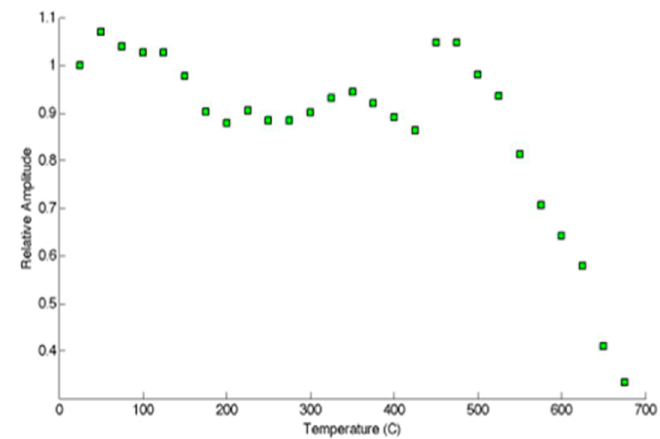
Figure 7. Temperature dependence of pulse-echo amplitude for Bi 4 Ti 3 O 12 / LiNbO 3 piezocomposite spray-on transducer [29].